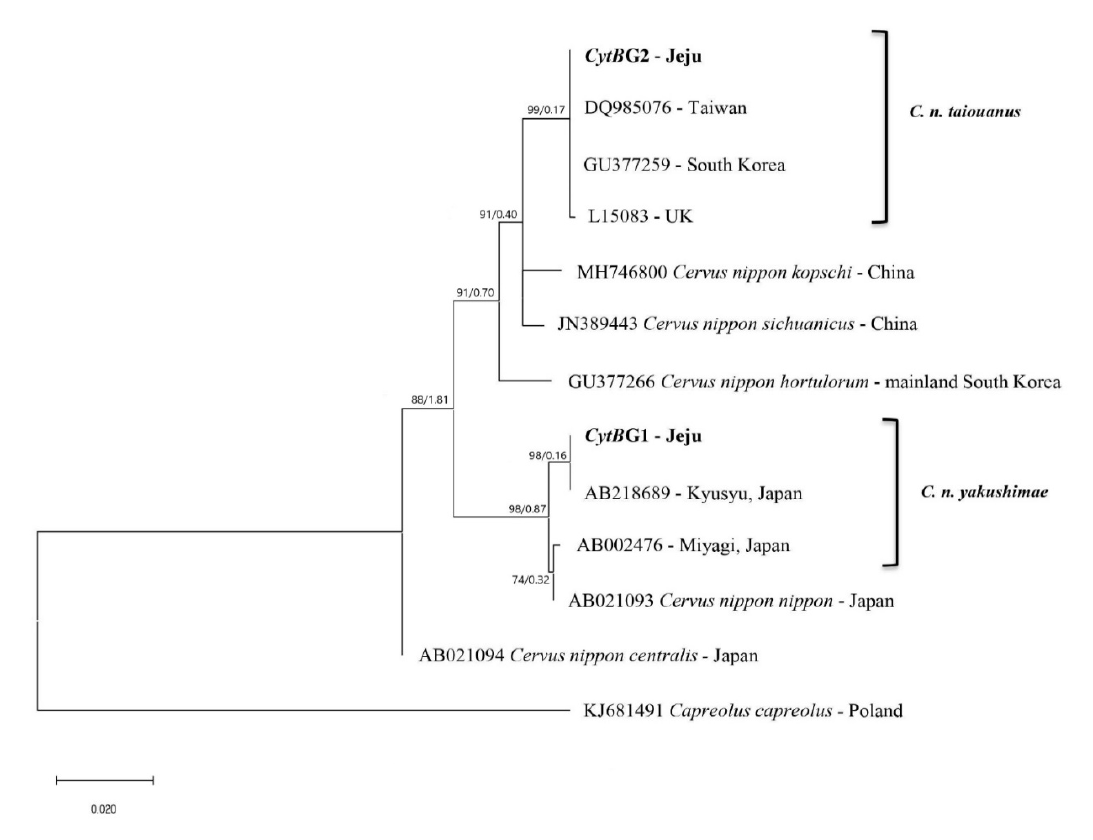
Figure 2. Maximum likelihood (ML) phylogenetic tree based on the mtDNA CytB gene sequences for two haplotypes of C. nippon collected from Jeju Island and reference sequences of various Cervids collected from the NCBI database. The numbers at each node represent bootstrap value and tentative divergence time, respectively. The tentative divergence time was estimated in million years. CytB gene sequences of 10 Cervid species were used as reference sequences and Capreolus capreolus was used as an outgroup. Detailed information of haplotypes and sequences determined in this study are presented in Table